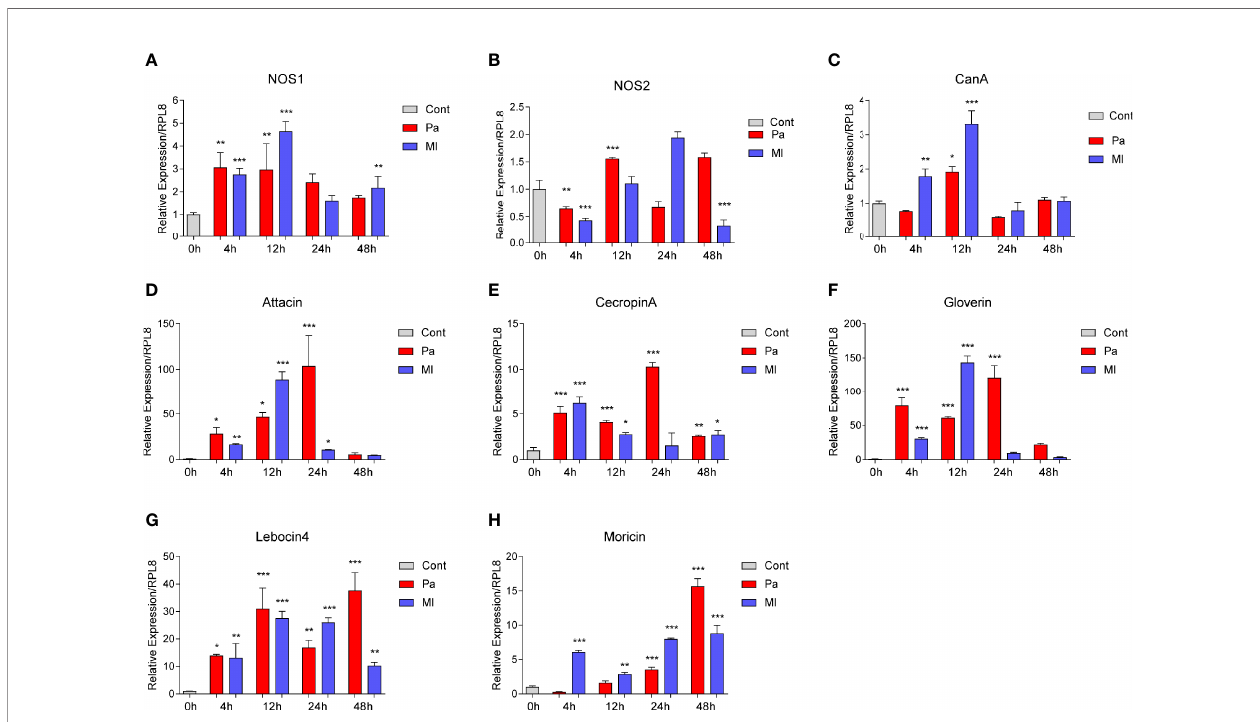
FIGURE 2 | Expression changes of NOS , CanA and AMPs in O. furnacalis larvae after bacterial infection. mRNA level changes in NOS (A, B) , CanA (C) , Attacin (D) , Cecropin A (E) , Gloverin (F) , Lebocin4 (G) , and Moricin (H) in whole O. furnacalis larvae at certain times post 1×10 4 cells of P. aeruginosa or M. luteus infection. Cont, PBS as control; CanA, calcineurin A; NOS, nitric oxide synthase; Pa, P. aeruginosa ; Ml, M. luteus . One-way ANOVA analysis followed by Tukey ’ s test was used to compare the control and infected groups. * p < 0.05; ** p < 0.01; *** p <